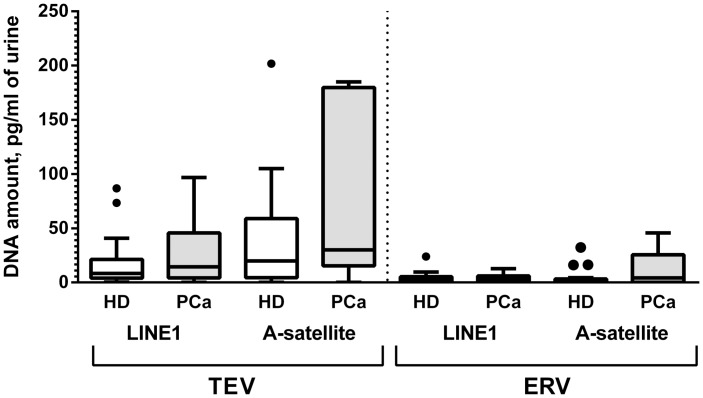
DNA in preparations of urine EVs.Tukey box plots of DNA concentration in preparations of EVs isolated from the urine of PCa patients and HD was determined using quantitative multiplex TaqMan PCR for LINE1 and α-satellite human DNA repeats.